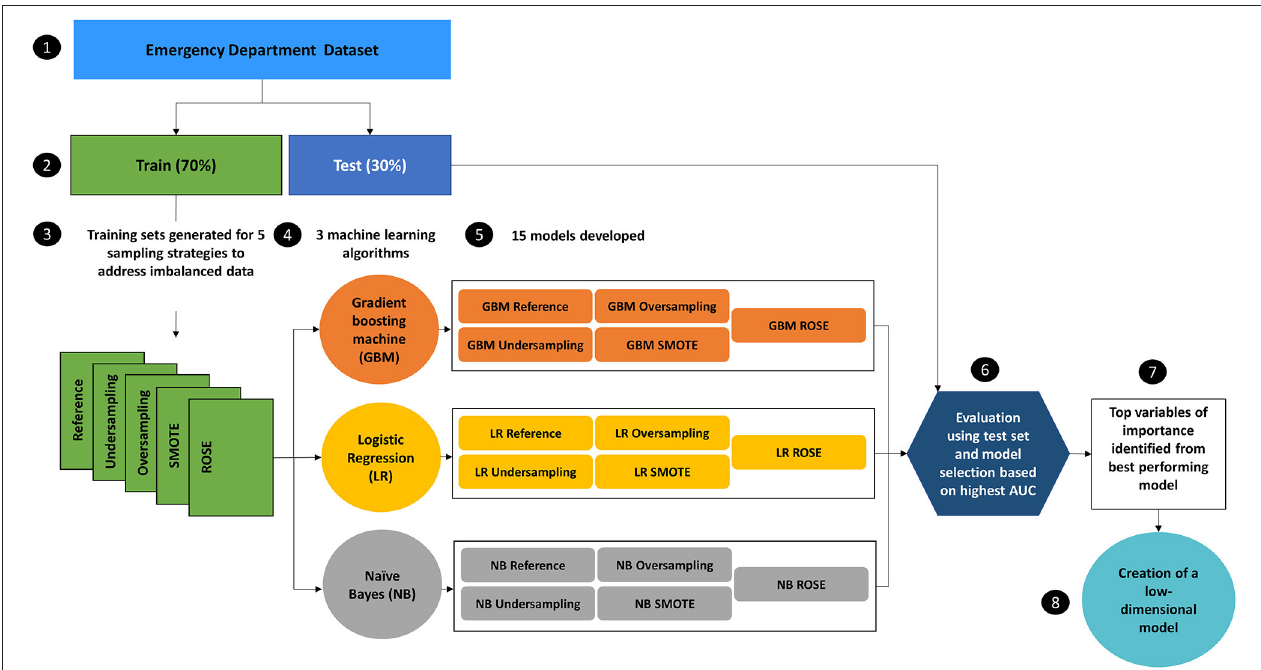
FIGURE 1 | Design of experiment to identify the model with the highest Area Under the Curve (AUC) from 15 models which will be used to obtain the variables of importance for the creation of a low-dimensional model. The reference training set will have no additional sampling technique applied.